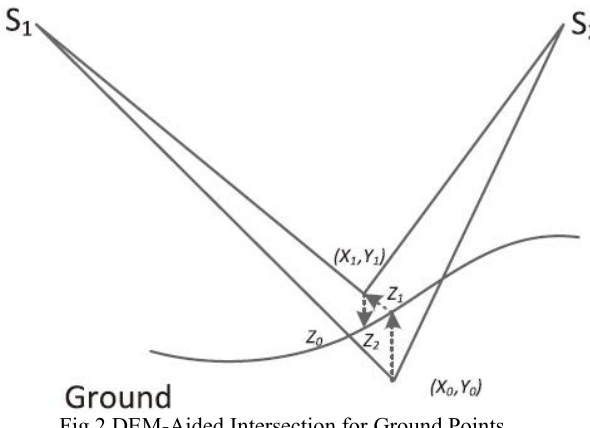
Fig.2 DEM-Aided Intersection for Ground